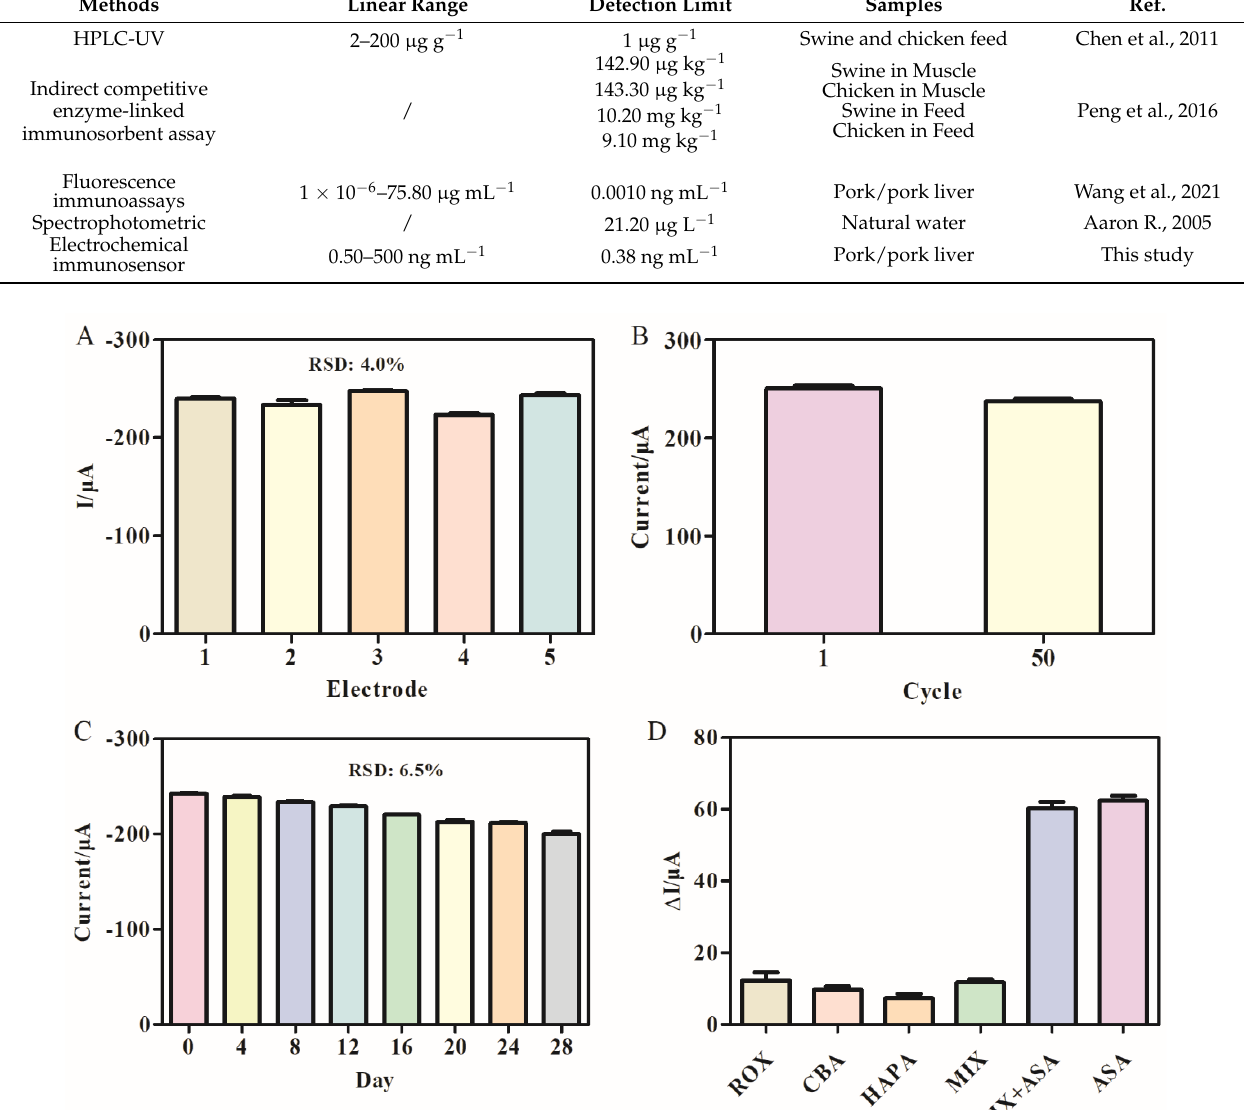
Table 2. Analysis of the immunosensor for ASA in real samples.